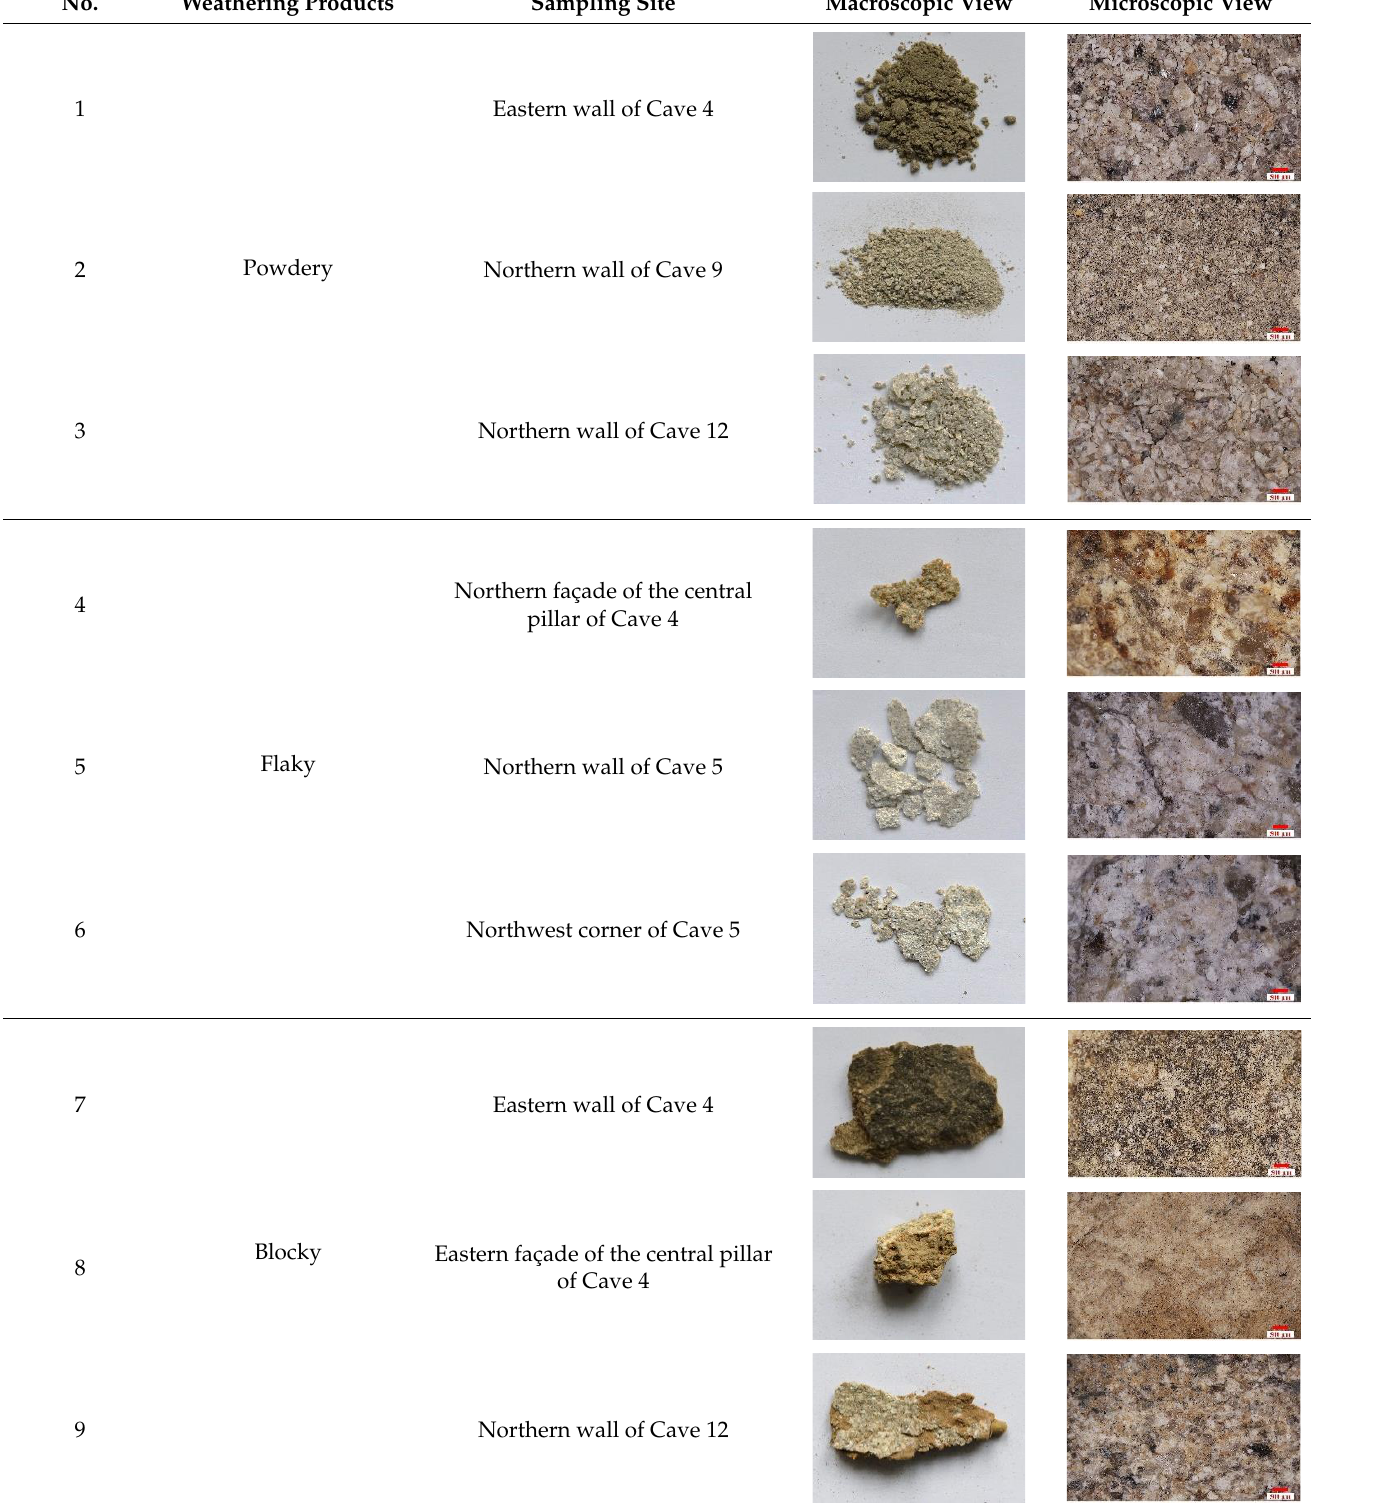
Figure 4. Chemical analysis of sandstone samples in the Yungang Grottoes: ( a ) sulfur content and ( b ) mineralogical composition. 3. Laboratory Experiments 3.1. Material The Yungang Grottoes lie in the northwestern limb of the Jinhuagong Syncline. The outcrop of sedimentary strata in this area is dominated by the Middle Jurassic Yungang Formation, a lens body of medium- to coarse-grained quartz sandstone interlayered with mudstone and sandy mudstone, covered by two layers of quaternary sediments. The sandstone contains mainly quartz, feldspar, calcite, and clay minerals such as kaolinite. The grain size varies in a wide range (from about 90 to 2000 μ m), while the roundness changes from sub-rounded to sub-angular [29]. The texture can be characterized as grain- supported with pores filled by clay matrix and carbonate cement (Figure 5). After cutting large blocks of fresh Yungang sandstone into 5 cm × 5 cm × 5 cm cubes, all specimens were oven-dried to constant mass at 105 ℃ and cooled to room temperature in a desiccator. For the sake of representativeness, cubes with similar P-wave velocities